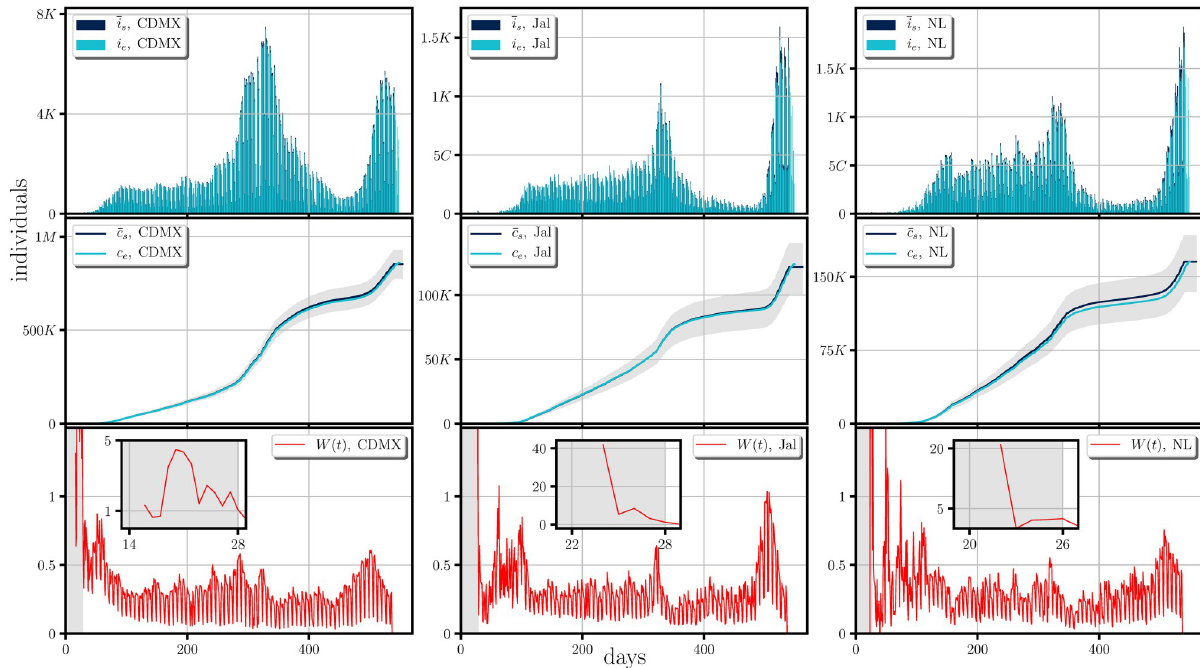
Fig 5. Comparison between the synthetic data generated by the stochastic model and real scenarios happening in some Mexican states and the form of their corresponding weight functions. The figure shows a comparison of the incidence (first row) and its cumulative (second row), between the synthetic data ( � i and � c ) generated by the stochastic model when averaged over 1000 trajectories to the real scenarios ( i s s Mexico City(CDMX), Jalisco(Jal) and Nuevo Leo´n(NL). The shaded region for the cumulative of the incidence represents the 1st and the 3th quartil of the cumulative of the synthetic incidence generated randomly. The synthetic data was generated by employing the empirical estimation of the weight function (last row) obtained form Eq (16). The figure shows a period of roughly a year and a half of the spreading of the SARS-CoV-2 (from February 18th, 2020 to August 20th,